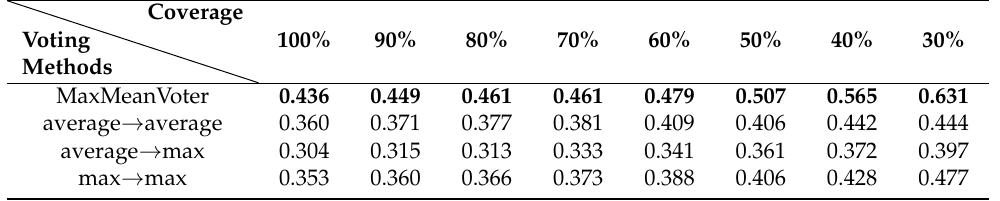
Table 5. Accuracy through different voting